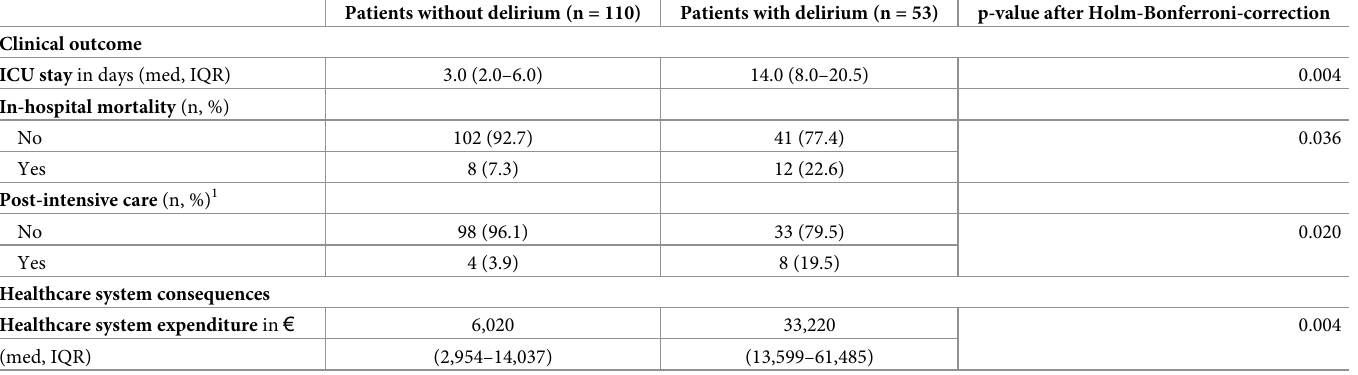
Table 5. Clinical outcome and healthcare system consequences of patients with delirium.